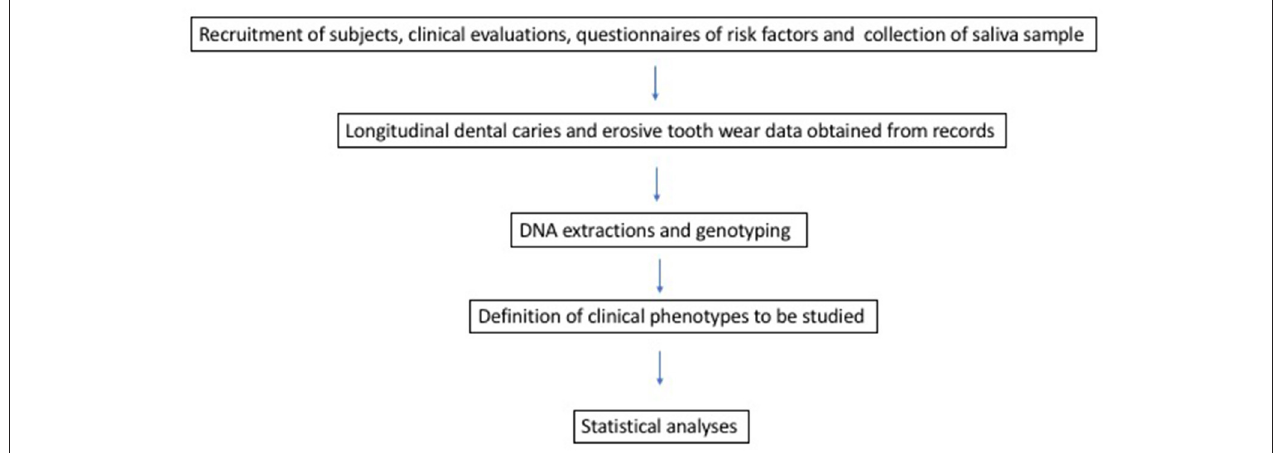
FIGURE 1 | Summary of study